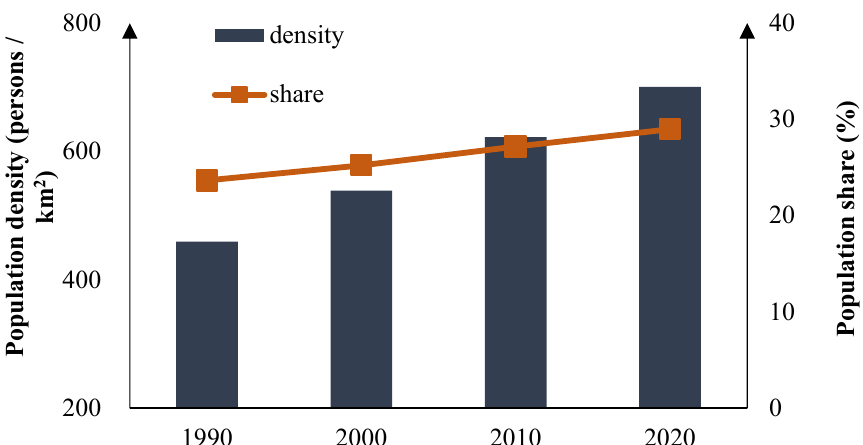
Figure 10. Changes in the population share and density of China’s coastal region.